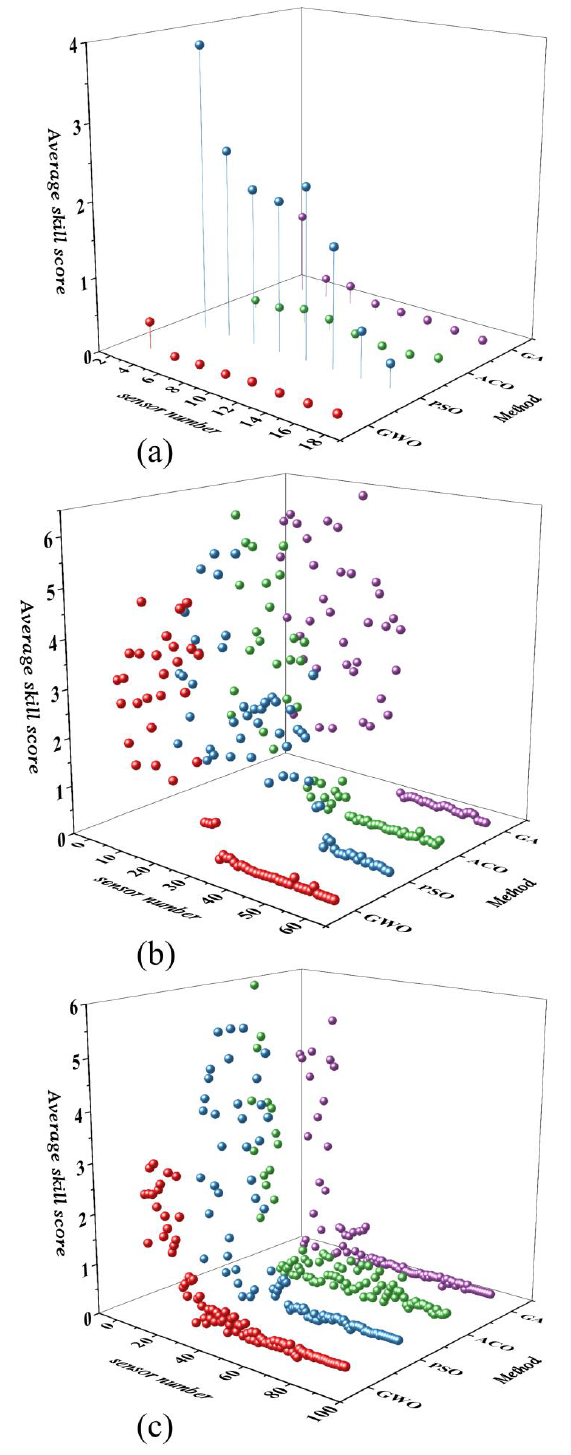
Figure 7. Comparison results of different optimization algorithms with different numbers of valid sensors. ( a ) in simulation case, ( b ) in run 17 and ( c ) in run